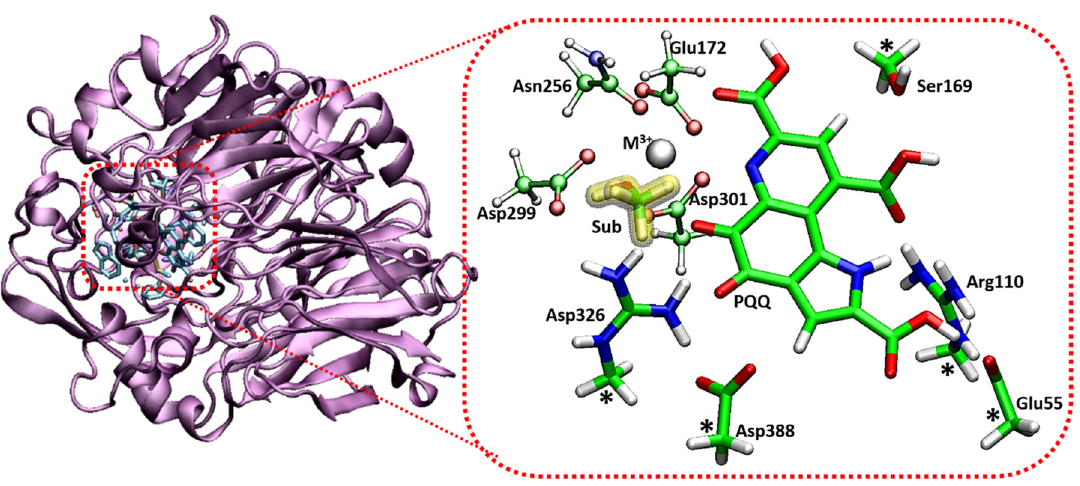
Figure 2. Quantum mechanics (QM) cluster model of M 3+ -MDH (M 3+ = Ce 3+ , Eu 3+ ) active site. Stars indicate the locked atoms frozen during the calculations.